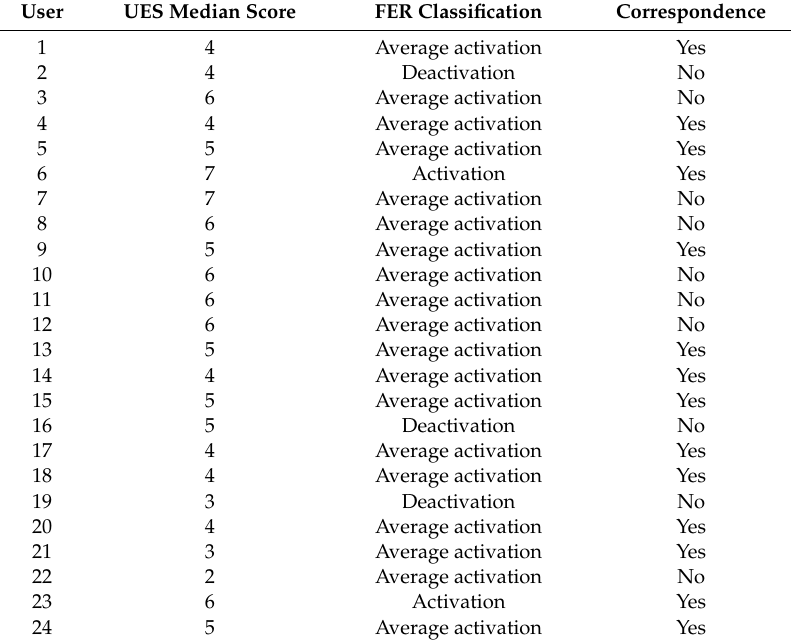
Table 4. Results of the UES questionnaire and facial expression analysis and recognition (FER) classification. The last column shows for each user whether there is a correspondence between the two methods.